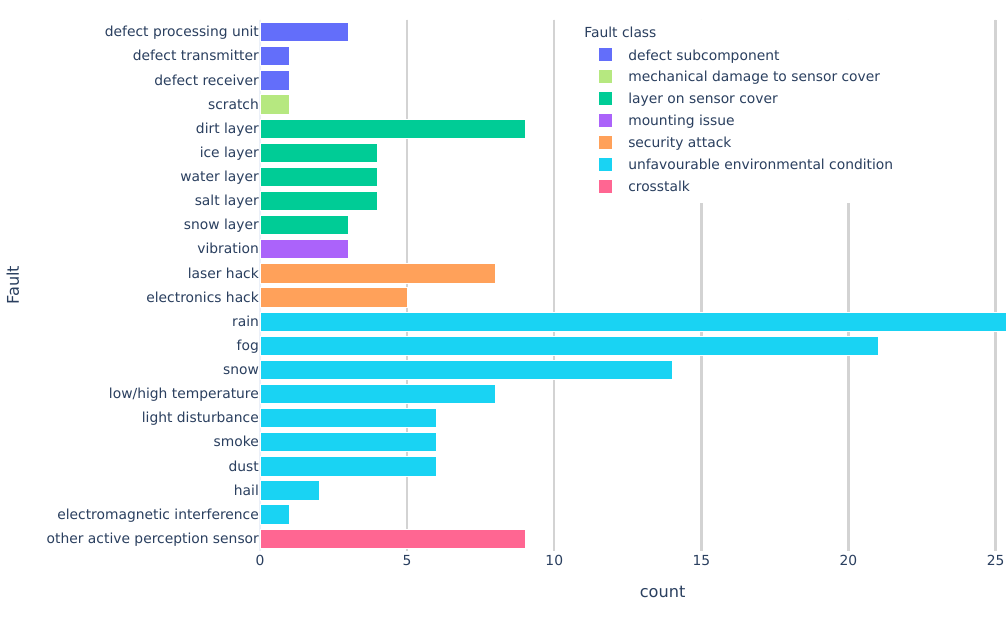
Figure 6. Counts of mentioned faults in the literature.